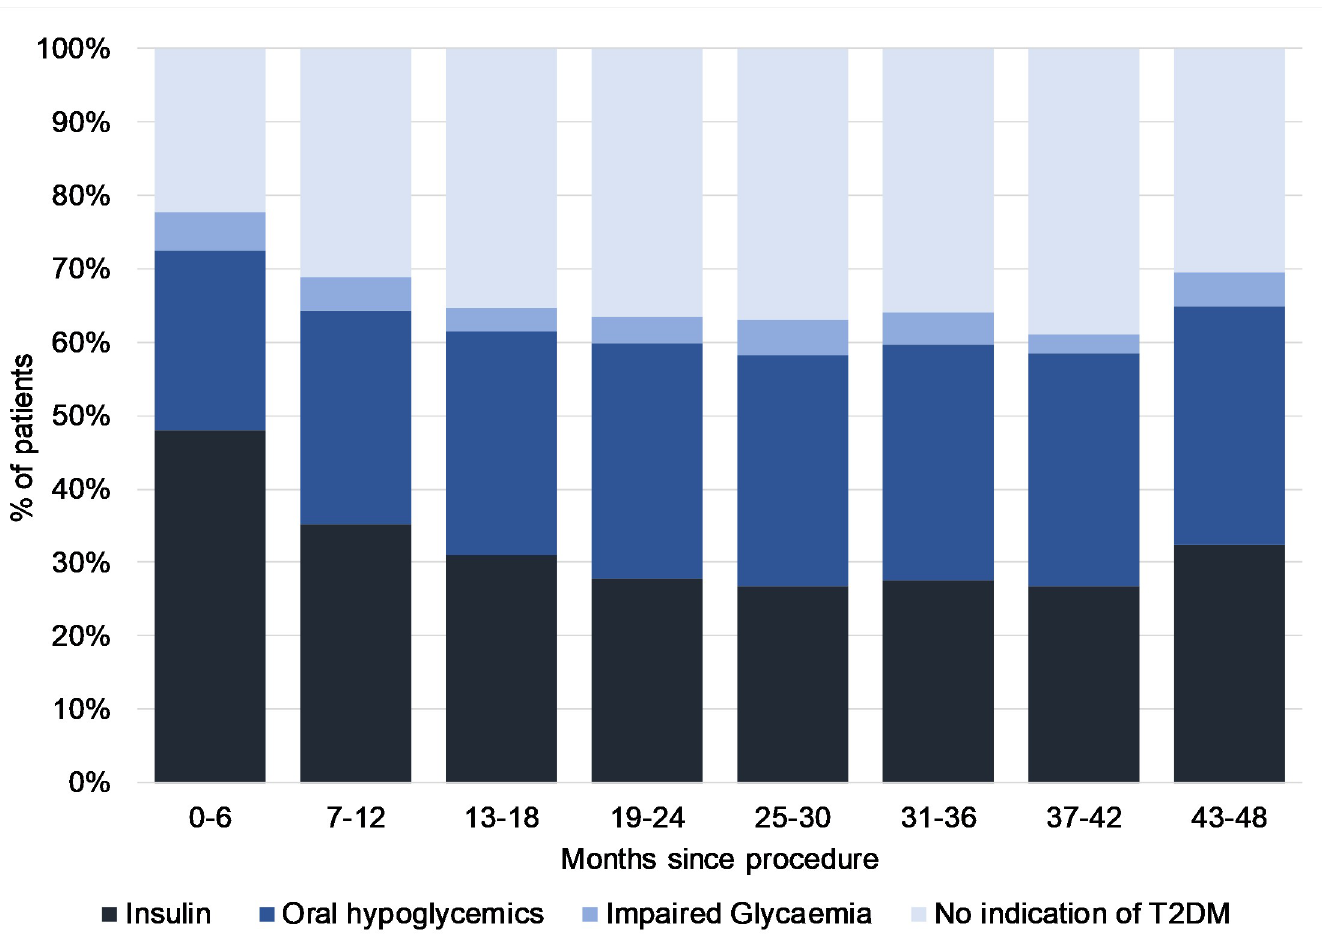
24 n = 639; month 25 to 30 n = 633; month 31 to 36 n = 251; month 37 to 42 n = 190; month 43 to 48 n = 108. T2DM, type 2 diabetes